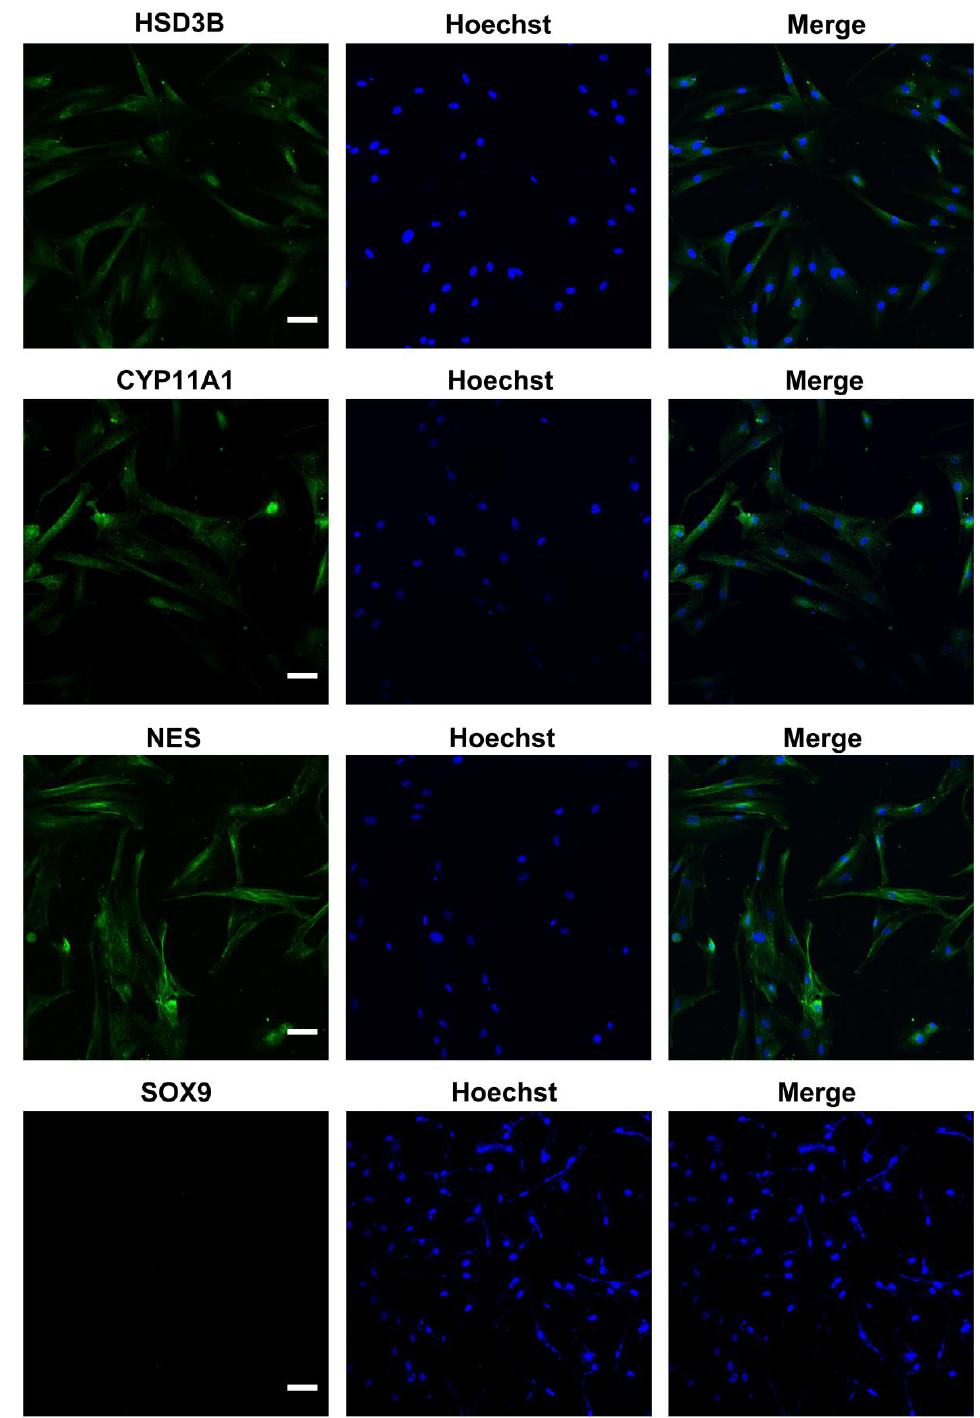
Figure 1. Identification of ALCs. Isolated cells were positive for LC markers (HSD3B, CYP11A1, NES) but negative for SC marker SOX9. The scale bar represents 100 μm.